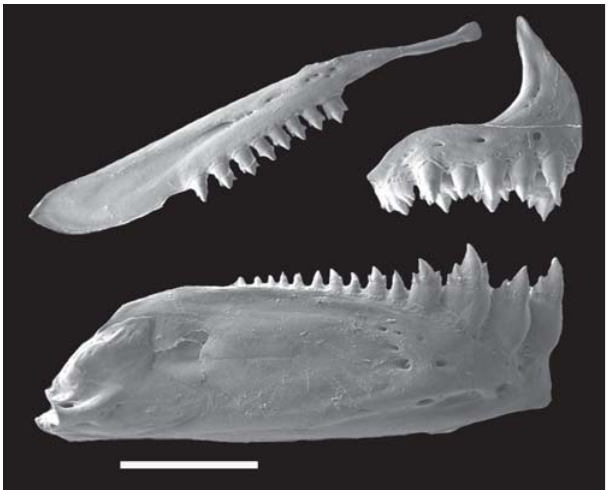
Fig. 15. Hemibrycon metae , MCNG 17030, female, 39.8 mm SL. Scanning electron micrograph of right side upper and lower jaws. Scale bar = 1